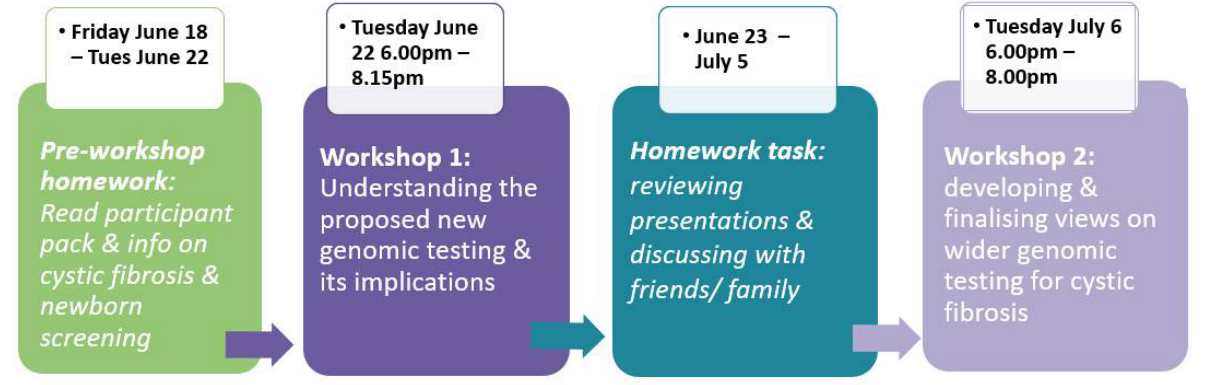
Figure 1. The mini-dialogue process: June–July